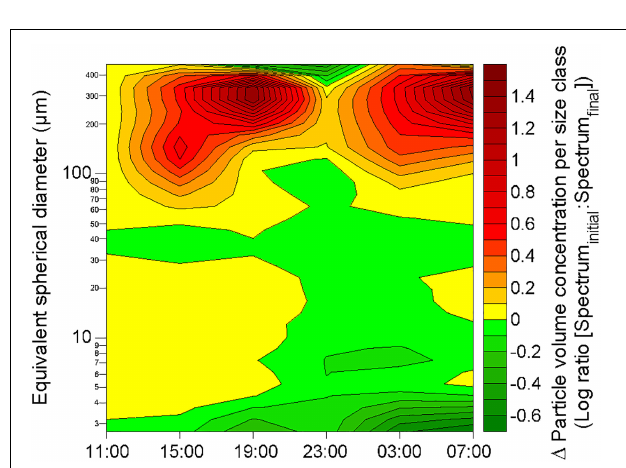
FIGURE 9 | Continued from a data grid of about 1300 points (i.e., 32 size classes on the x -axis, and from 30 to 40 size spectra on the y -axis).